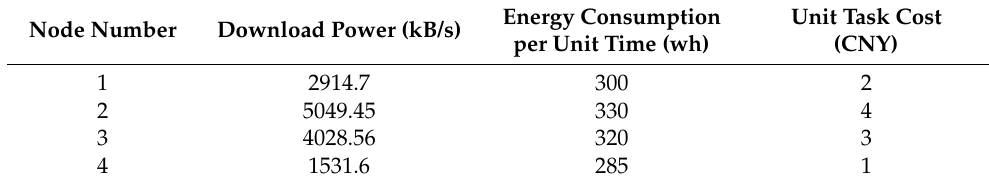
Table 1. List of node